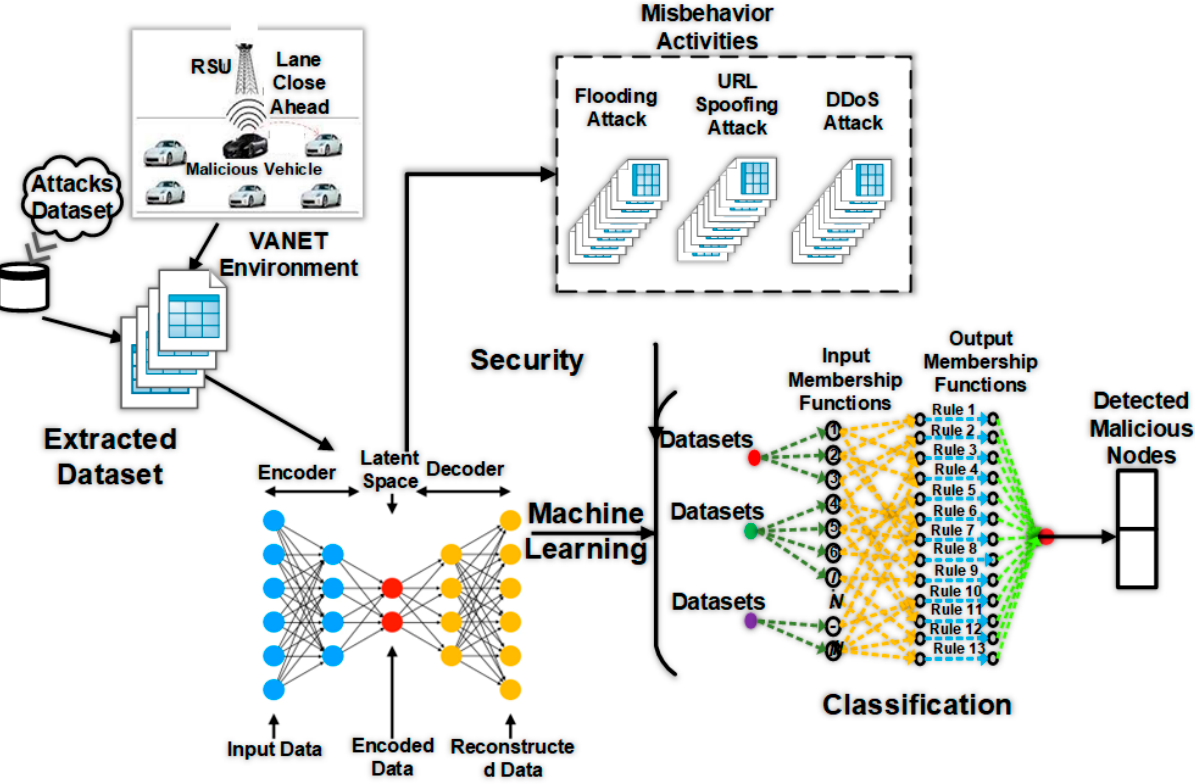
Figure 8. Malicious node detection technique using machine learning.